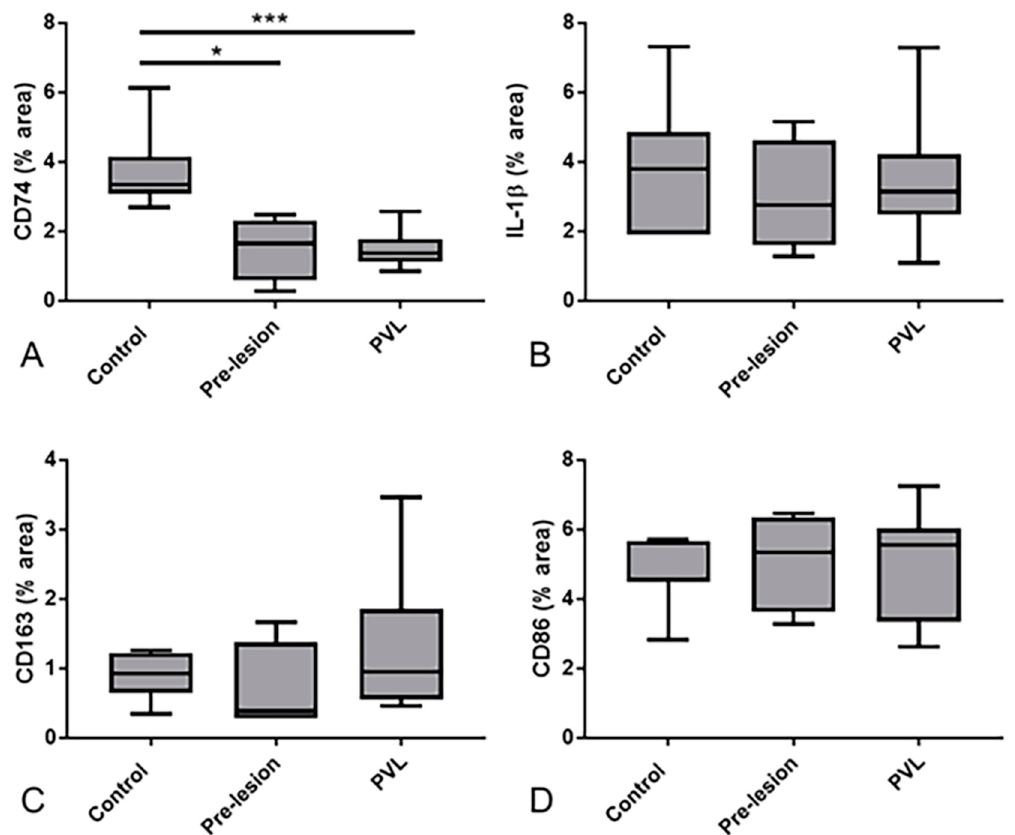
Figure 5. Quantitation of the expression of candidates in periventricular ageing white matter. The percentage area immunoreactivity of the protein encoded by a panel of candidate genes was assessed in the three periventricular white matter groups. ( A ) CD74 expression was significantly higher in non-lesional control periventricular white matter compared to both “pre-lesional” ( p = 0.033) and PVL ( p = 0.003). The immunoreactive profiles of ( B ) IL-1 β , ( C ) CD163 and ( D ) CD86 did not significantly differ across the three groups. * p < 0.05, *** p < 0.005.